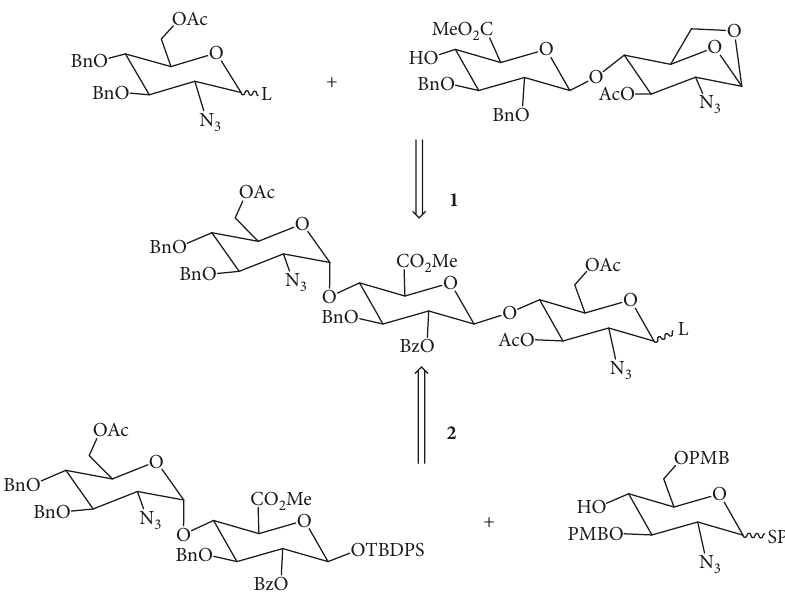
Scheme 8: Two synthetic strategies for synthesis of trisaccharide fragment